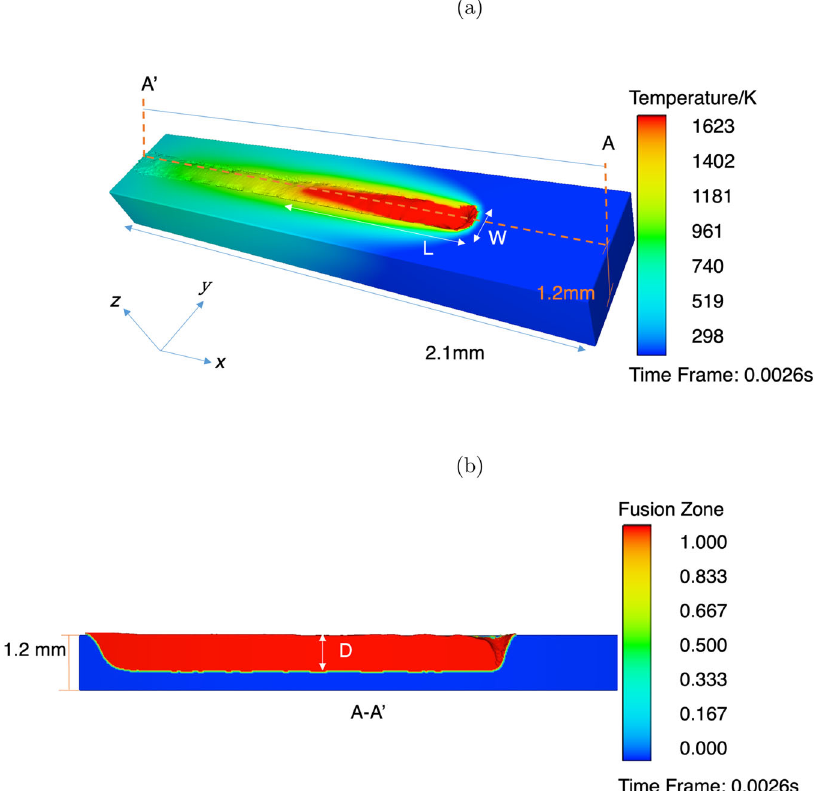
Fig. 8 Typical simulation results with corresponding colour scales. a Isometric view with temperature scale, where L and W denote the melt pool length and width respectively. b Vertical cross sectional view of melt pool depth with fusion scale---where 1 represents the region that has ever been melted, while 0 represents the region that has never been